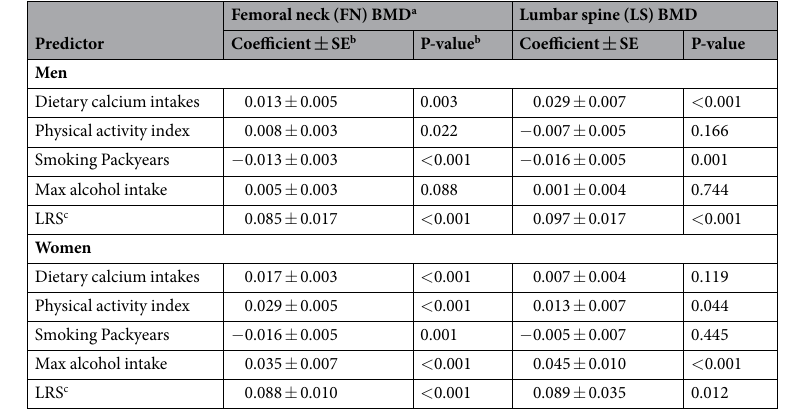
Table 2. Lifestyle determinants of BMD using multiple linear regression analysis. a BMD: Bone mineral density. LRS: Lifestyle Risk Score. b SE: standard error. P-value is for the coeffiecients in the linear regression analysis. c I(LRS/0.1). Notes: Lifestyle predictors are normalized using zscores. Coefficients of linear regression are adjusted by age and body mass index.